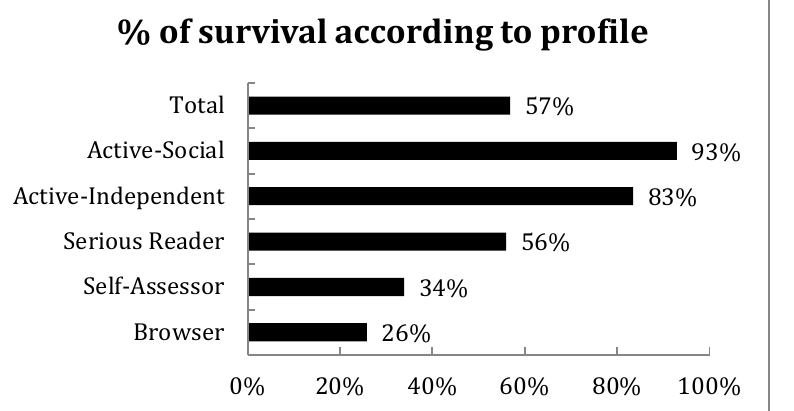
Figure 2. Results of survival analysis until week 7 for the five profiles obtained with cluster analysis (excluding Ghost).